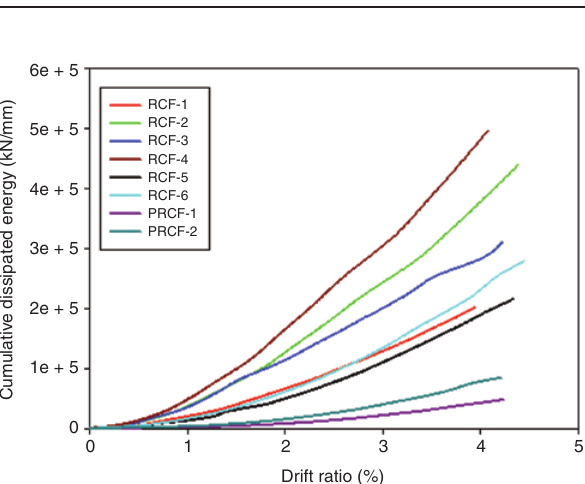
Figure 11: Displacement ductility of the test frames for pull and push directions.